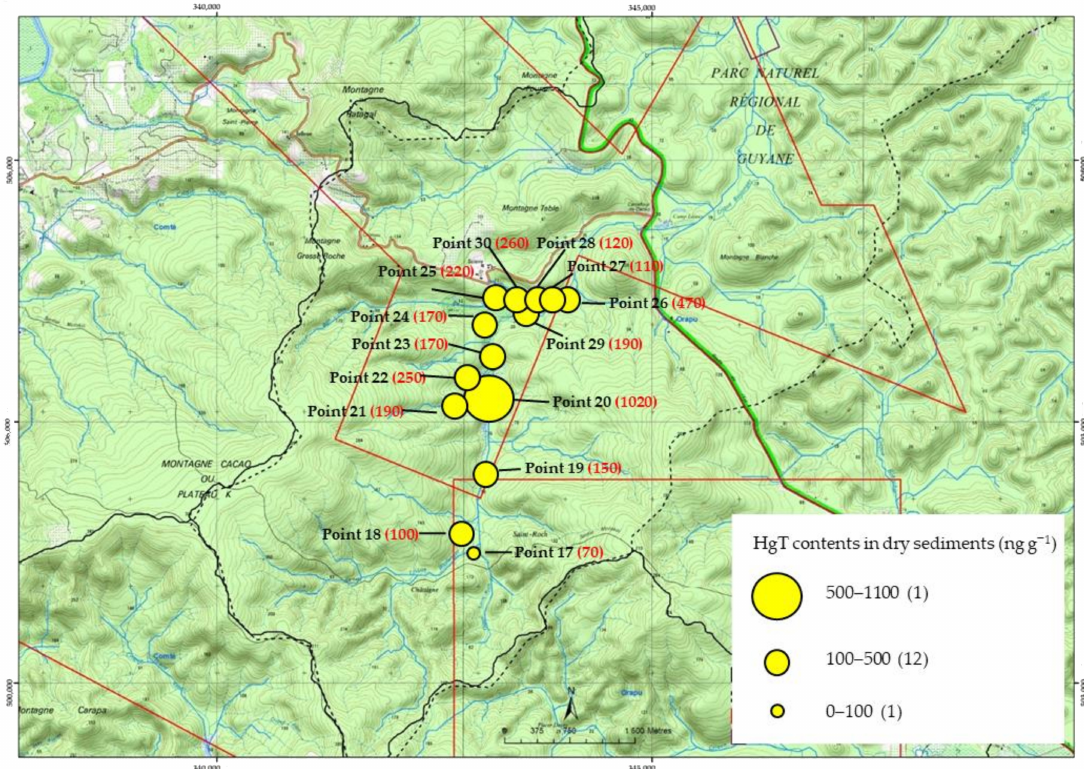
Figure 2. Localization of samples taken from old tailing ponds in the Boulanger concession in the dry season of September 2012 and total mercury (THg) contents (ng g − 1 ). Points 17–24 are tailing ponds dating before the mercury (Hg) ban for gold mining in 2006, whereas points 25–30 are more